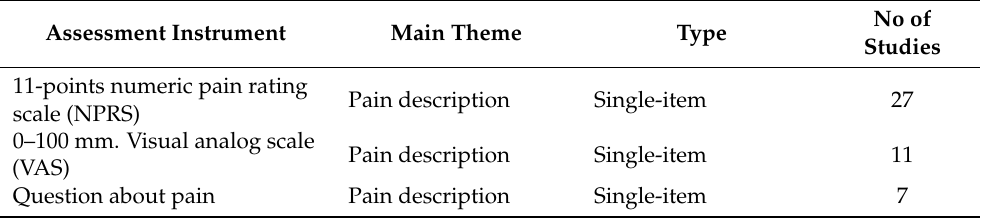
Table 1. Frequency and thematic focus of assessment instruments included (identified in 4 or more